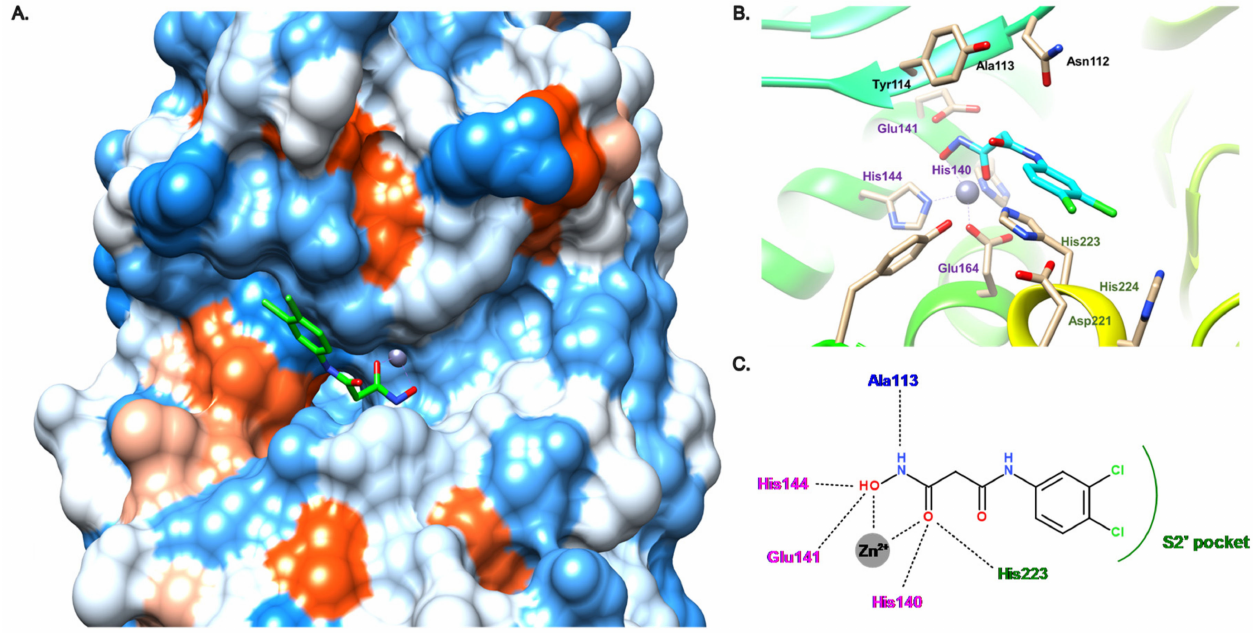
Figure 10. Binding mode of 16 from PDB entry 6FZX [45]. ( A ) View of the active site of LasB, in surface mode, accommodating 16 (green) visualized using Chimera 1.15. The zinc cation is represented as a gray sphere. ( B ) View of the active site of LasB with 16 (blue) and key residues (gray sticks) involved in the binding visualized using Chimera 1.15. ( C ) Two-dimensional schematic representation of the binding mode of 16 . The key interactions are indicated as dashes, the zinc cation is represented as a gray sphere, and the key residues are indicated in pink for those belonging to the S1 (cid:48) pocket, green for those belonging to the S2 (cid:48) pocket and blue for the